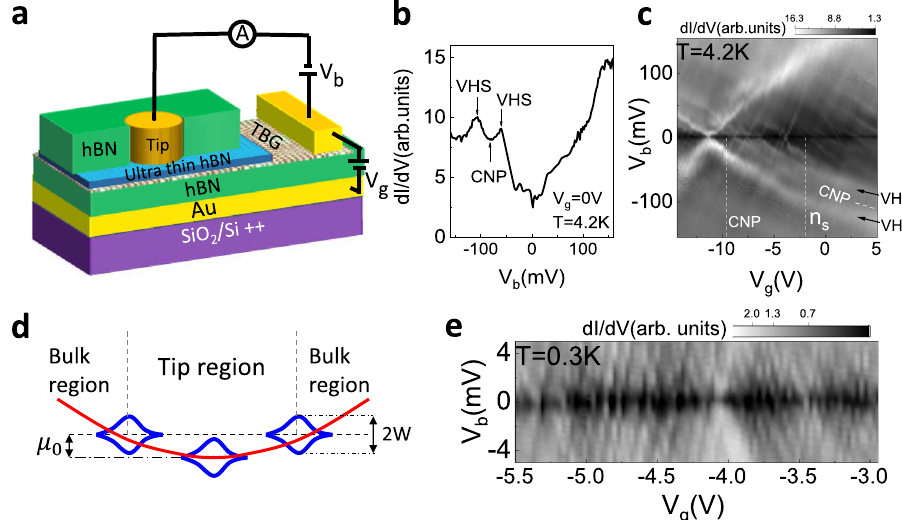
Fig. 4 Carrier con fi nement in a TBG planar tunneling device. a Schematic of the planar tunneling device. An ultra-thin hBN acts as a tunneling barrier between the metallic tip and the TBG. b Tunneling spectrum measured at 0 V backgate voltage showing the fl at bands. The sample is highly n-doped because of the work function difference between the tunneling electrode and the TBG. c Gate dependence map of the STS. Flat bands can be seen as two bright parallel lines at negative bias. The other features are a result of con fi nement. d Schematic of the position dependence of the charge neutrality point. μ is the shift in the charge neutrality point under the tip compared to the bulk region. e High resolution dI = dV b gate dependence maps measured at 0.3 K 0 showing coulomb diamonds, a result of electron con fi